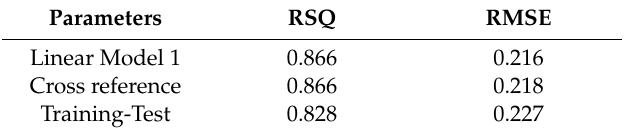
Table 6. Comparison of the values of R-squared (RSQ) and root mean square error